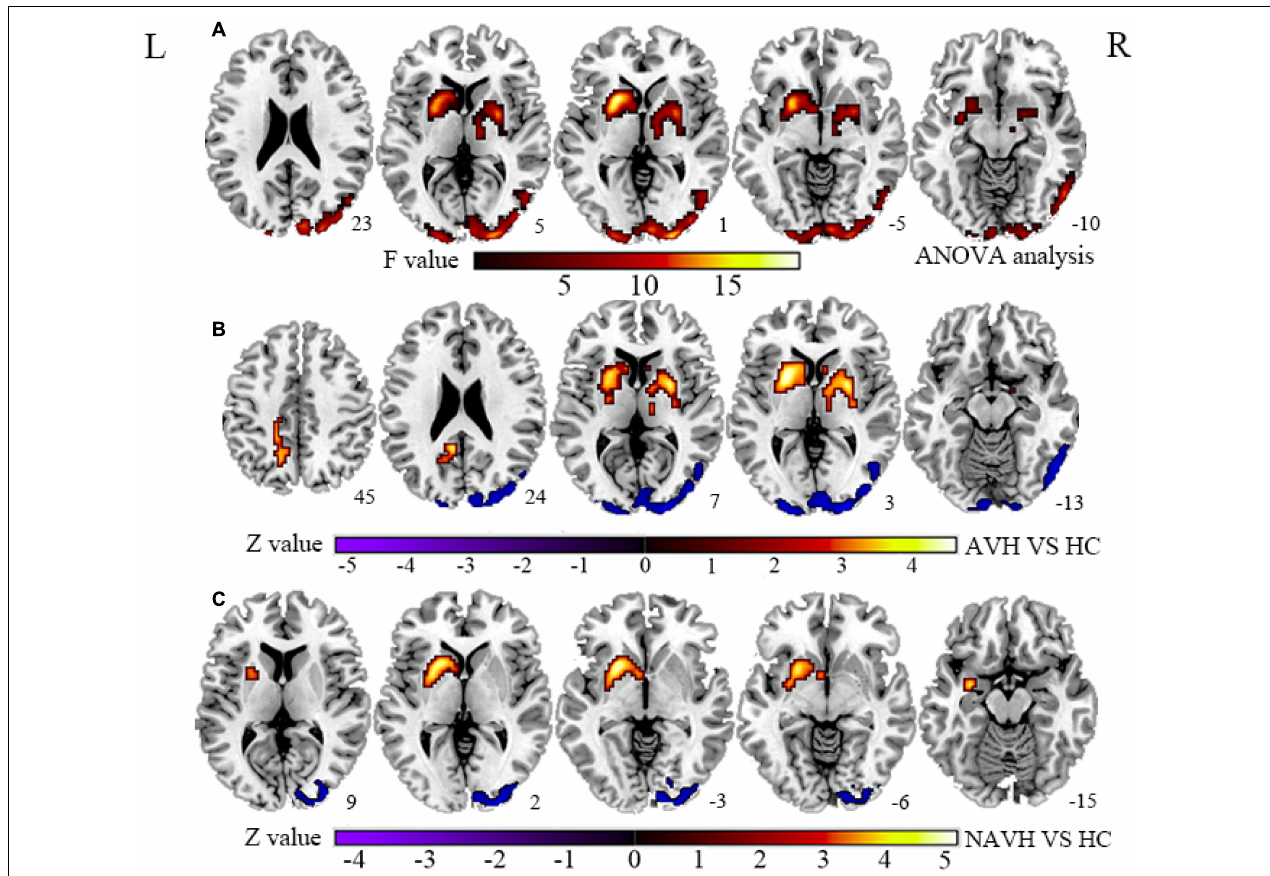
FIGURE 1 | (A) Brain regions with significant CBF changes between the AVH, NAVH, and HC groups. (B) Brain regions with significant CBF changes in the AVH group. (C) Brain regions with significant CBF changes in the NAVH group. CBF, cerebral blood flow; AVH, schizophrenia patients with AVHs; NAVH, schizophrenia patients without AVHs; HC, healthy